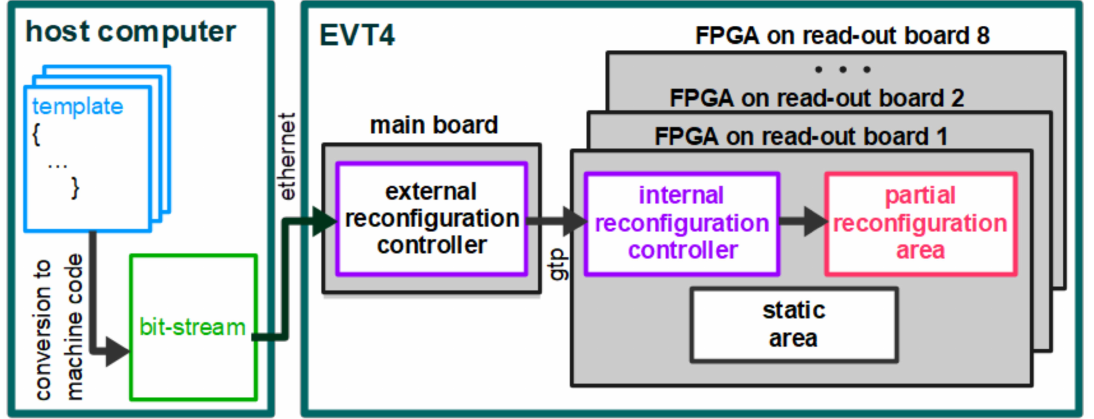
Figure 7. Elements of reconfiguration